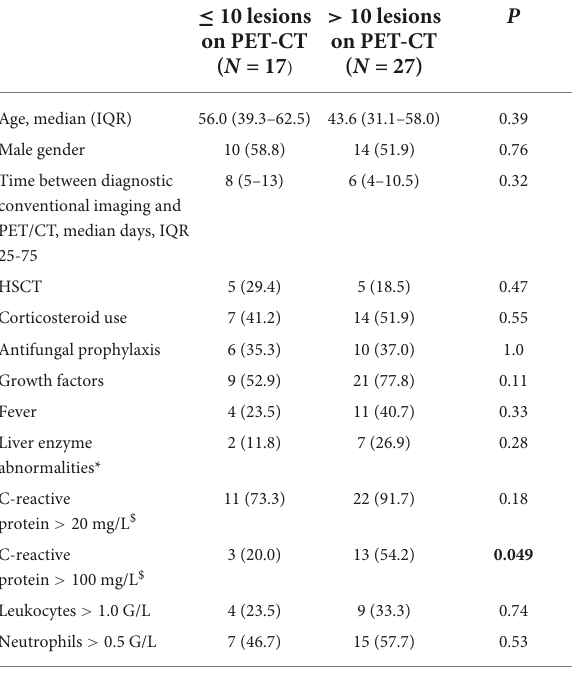
TABLE 3 Comparison of clinical and biological parameters in patients with > 10 lesions vs. ≤ 10 lesions on baseline positron-emission tomography computed tomography